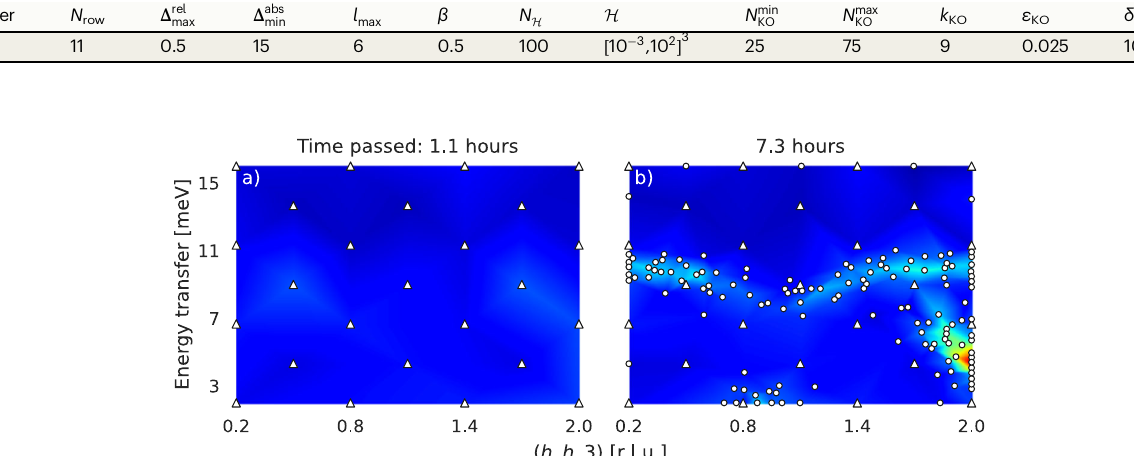
Fig. 5 | Results for scenario 2. For the Q direction, we use relative lattice units (r.l.u.). a Reduced number of initial measurement points (triangles) in a modi fi ed domain providing almost no initial information about the intensity function. b Intensity observations (dots) autonomously placed after the uninformative